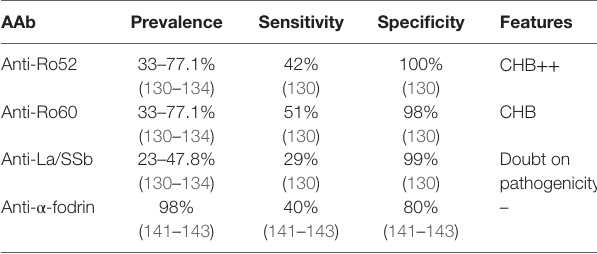
TAble 3 | AAb associated with Sjögren’s